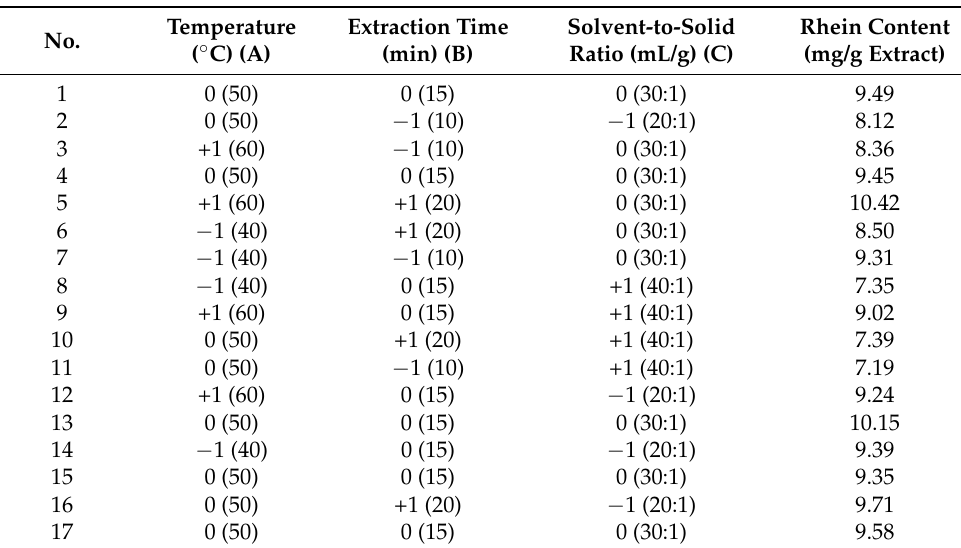
Table 3. Coded (actual) levels of the operational parameters and observed values of